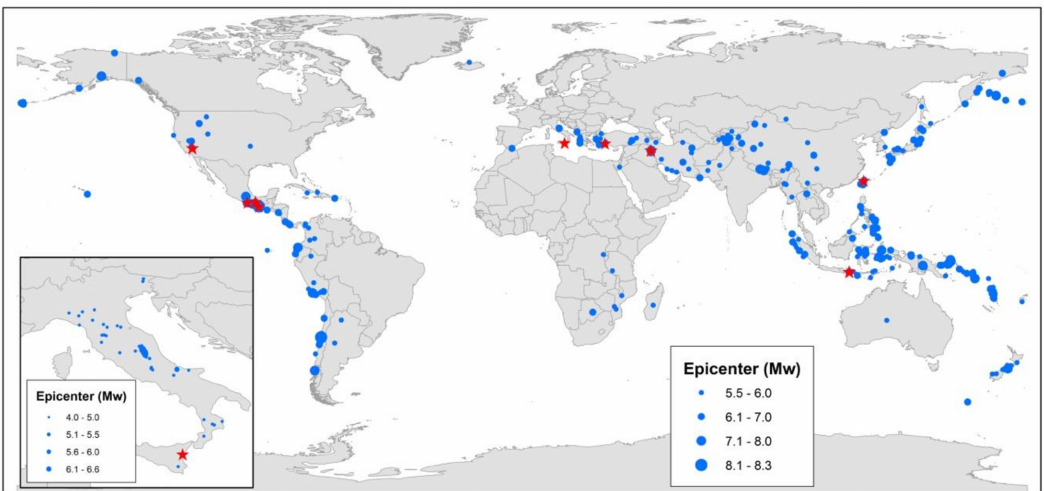
Figure 2. Earthquake locations from January 2015 to July 2020 that have been analyzed with our Sentinel-1 automatic DInSAR tool. The inset on the left shows a close-up of Italy. Magnitude class legends are also provided. Red stars represent the earthquakes analyzed in Section